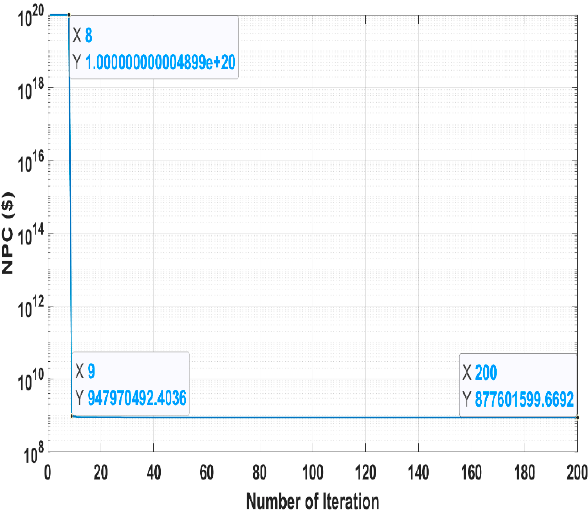
Figure 4. Cost Distribution of Different Energy Systems.